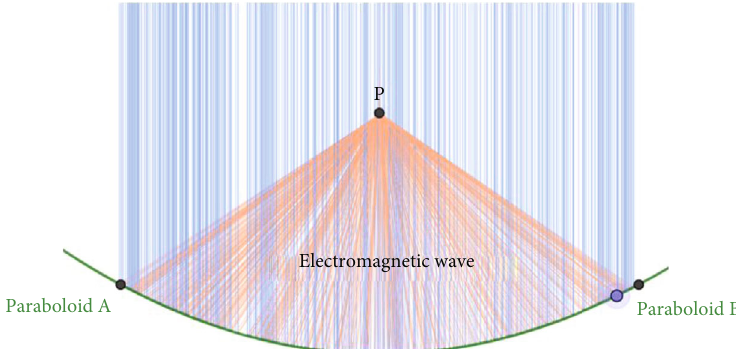
Figure 7: Schematic diagram of the projection of parabolic re fl ected electromagnetic wave.